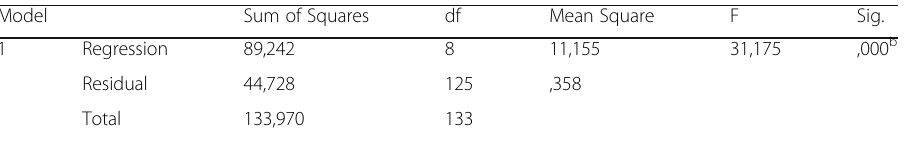
Table 24 ANOVA R5